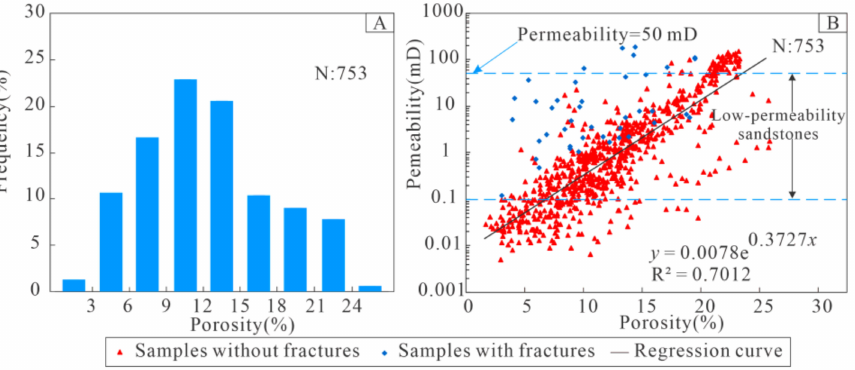
Figure 3. Reservoir porosity histogram ( A ) and porosity–permeability cross-plot ( B ) of the E s4 sandstone reservoirs in the Dongying